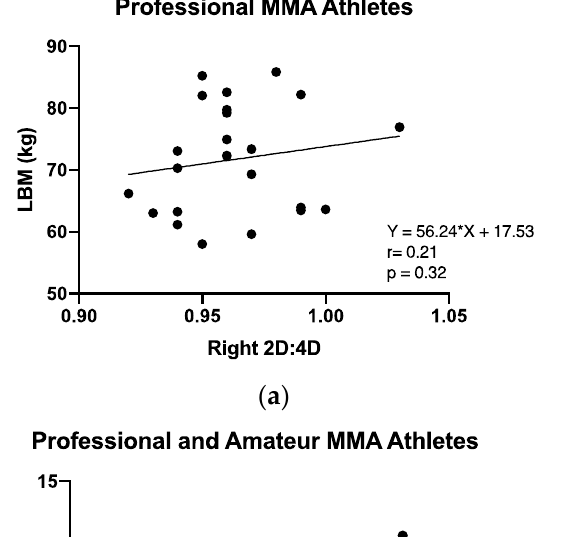
Figure 3. ( a ) Spearman’s correlation test between LBM and right 2D:4D among professional MMA athletes ( p = 0.32. ( b ) Spearman’s correlation test between LBM and left 2D:4D among professional MMA athletes ( p = 0.01). ( c ) Spearman’s correlation test between the HGS index and right 2D:4D among professional and amateur MMA athletes ( p = 0.5). ( d ) Spearman’s correlation test between the HGS index and left 2D:4D among professional and amateur MMA athletes ( p = 0.002).